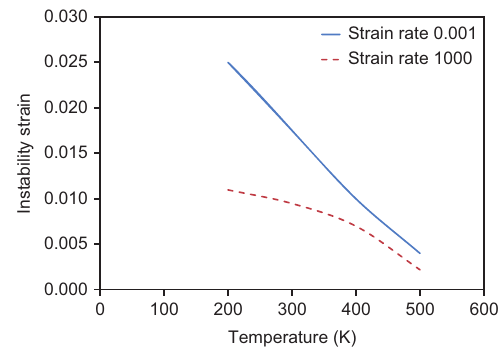
Figure 17 Occurrence of instability strain vs. temperature for CR-1018